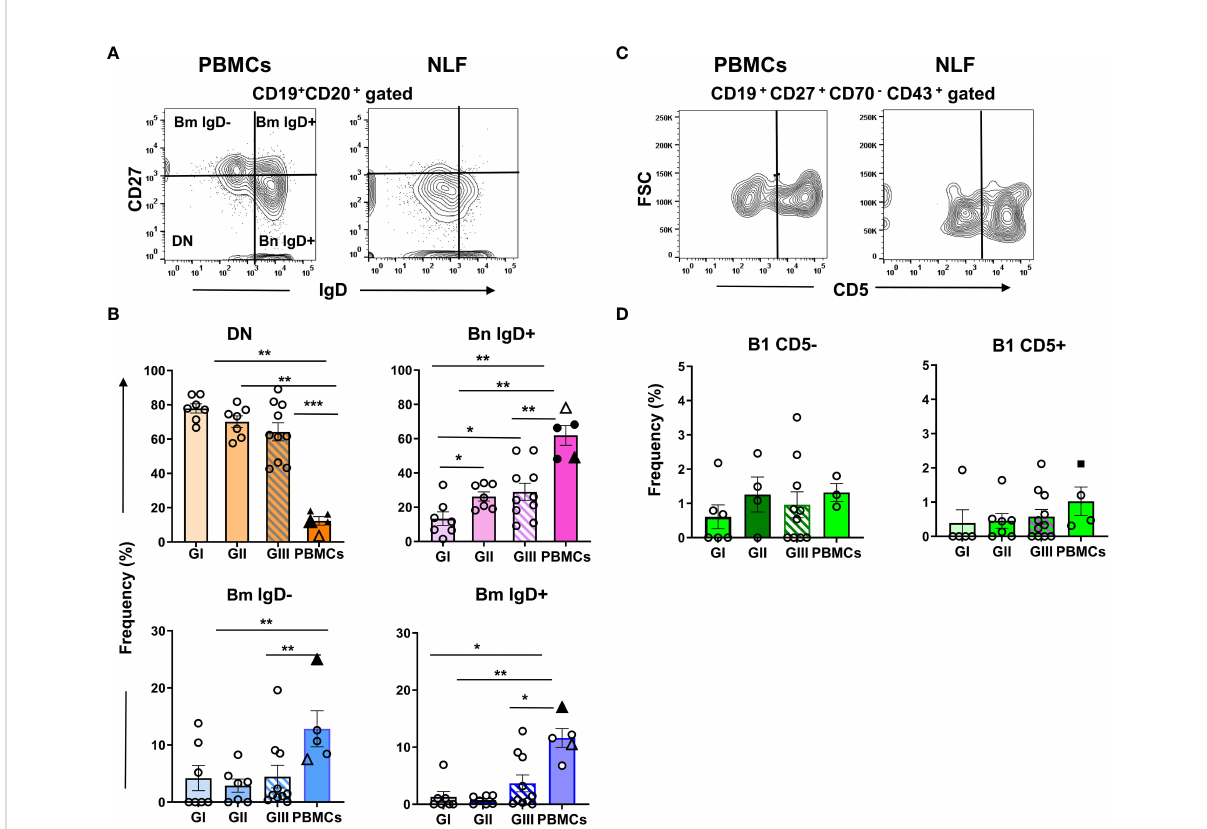
FIGURE 6 B cell phenotype in NLF from bronchiolitis affected infants. Cell suspensions were stained with the following MonAbs: anti-CD20, anti-CD19, anti-CD27, anti-IgD, anti-CD70, anti-CD43 and anti-CD5. Shown are contour plots of the indicated staining performed by using concatenated fi les from adult PBMC (n = 3) and from NLF samples (n = 5). (A) Contour plots of the CD27 and IgD staining on gated CD20 + B cells. The quadrants discriminate the B cell populations of naïve(IgD + CD27 - Bn), DN (IgD - CD27 - ) and memory (CD27 + Bm, IgD - and IgD + ). (B) Frequency of each B cell subset relative (%) to the total CD20 + cells on individual NLF and PBMC samples. The data are presented as scatter dot plots with the means ± SEM shown; GI (n = 7), GII (n = 7), GIII (n = 10), adult PBMC (n = 3). For comparison, the frequency obtained for adult PBMCs ( Sanz et al. , fi lled triangle) and that of PBMCs from 1-24 mo-old children ( Berro ́ n-Ruiz et al. , empty triangle) are shown. (C) Contour plots representing CD5 versus FSC-A on gated CD19 + CD27 + CD70 - CD43 + B1 cells. (D) Frequency of CD5 - and CD5 + B1 cell subsets as the % of the total CD19 + cells. Filled square shows the frequency obtained on adult PBMCs ( Rodriguez-Zhurbenko et al.). Data are represented as in (B) ; GI (n = 6), GII (n = 7), GIII (n = 11), PBMC (n = 3). Data were compared using non-parametric Mann-Whitney sum rank test. *p < 0.05; **p < 0.01; ***p <